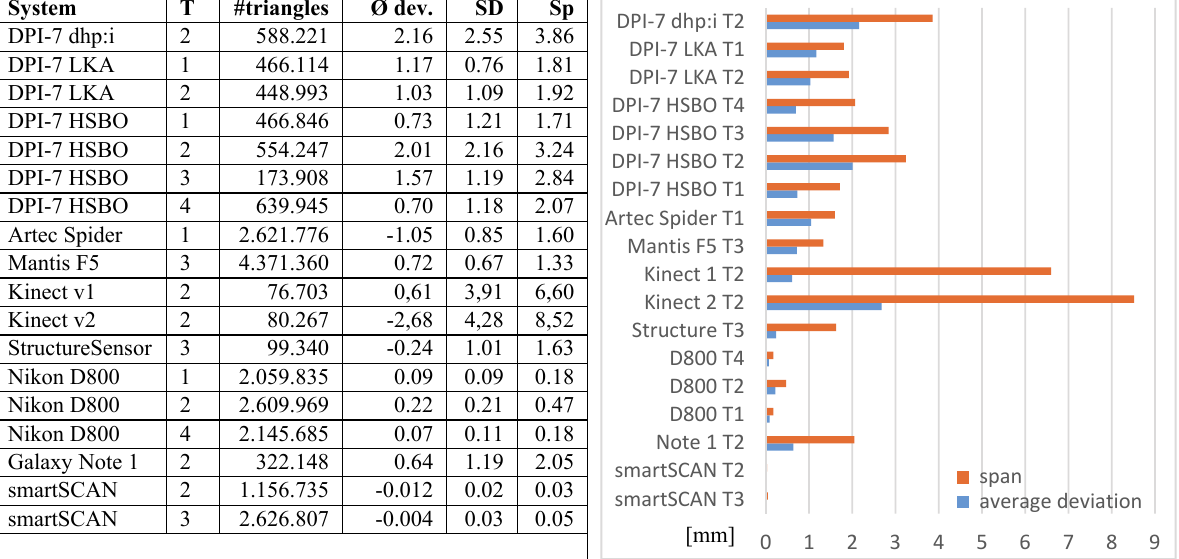
Table 2. Average deviations [mm] of the Testys (T = Testy, SD = Standard Deviation, Sp = Span) – 3D comparison in Geomagic Studio between reference (ATOS, # of triangles ca. 250.000) and test system